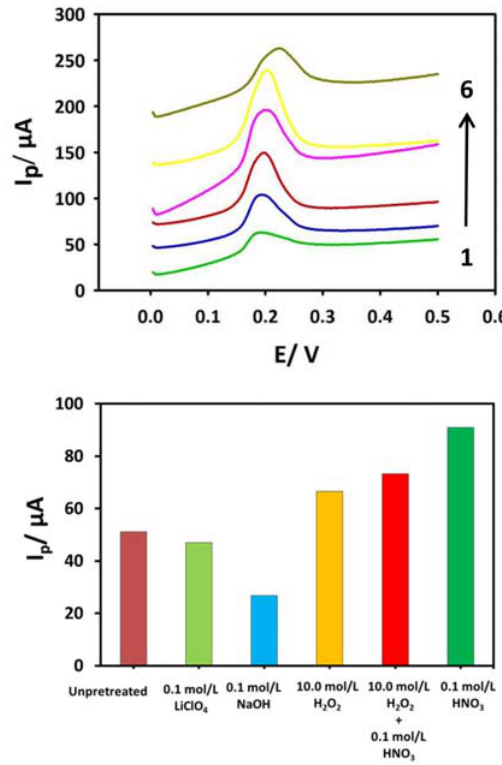
Figure 1: a) Square wave anodic stripping voltammograms (SWASVs) and b) corresponding histograms of 6.2 × 10 –7 mol/L Hg(II) in acetate buffer (0.1 mol/L, pH 5.5) at 1) carbon paste, 2) Pt, 3 Au. 4) glass carbon and 5) graphite pencil electrode. Working